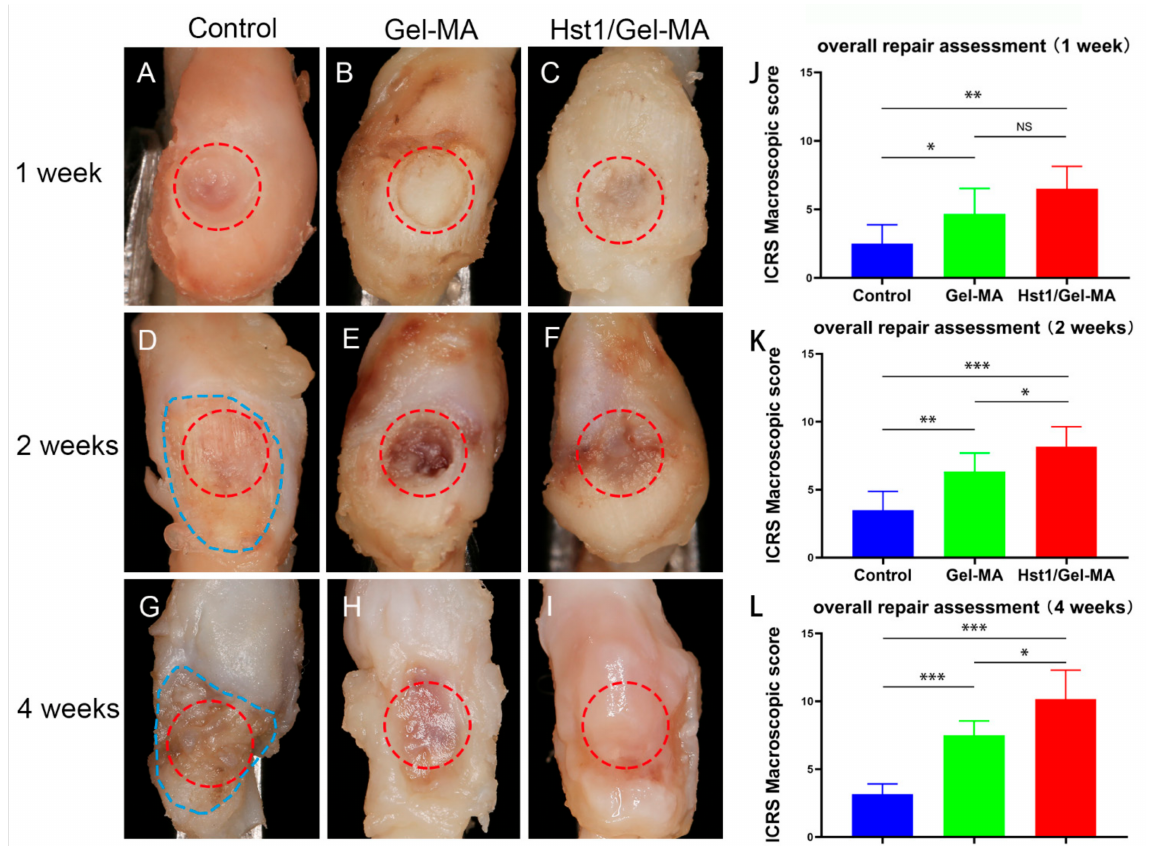
Figure 2. Photographs and macroscopic evaluation of rabbit condyle osteochondral defects of TMJ, which were treated as control group ( A , D , G ), Gel-MA group ( B , E , H ) and Hst1/Gel-MA group ( C , F , I ). The tissues were retrieved at 1, 2, and 4 weeks post operation and then photographed and scored using ICRS macroscopic scores ( J – L ). The red circle area represents the original defect area, and the blue irregular area represents the enlarged absorption area ( n = 6, * p < 0.05; ** p < 0.01; *** p < 0.001 and NS = not